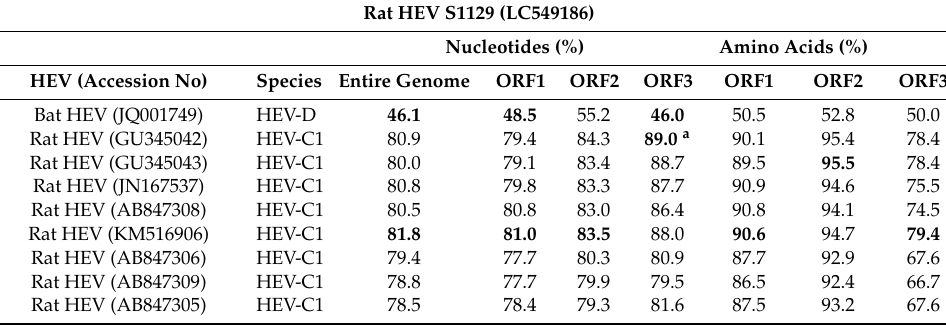
Table 2. Nucleotide and deduced amino acid-sequence identities between S1129 and other hepatitis E virus (HEV)